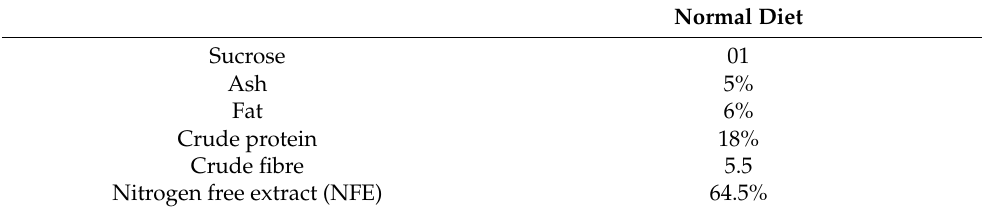
Table 1. Normal diet composition for